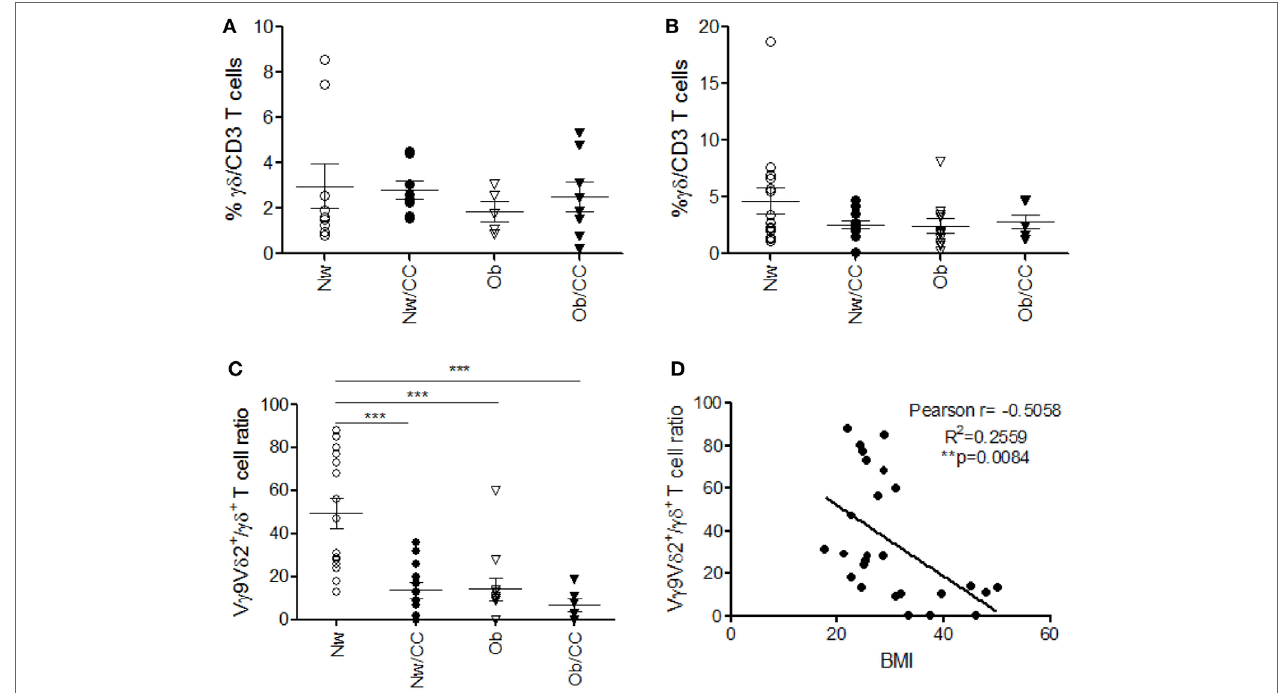
FigUre 5 | Obese (Ob) and colorectal cancer (CRC)-affected individuals exhibit normal frequencies of peripheral blood (PB) and visceral adipose tissue (VAT)- associated total γδ T lymphocytes but a significantly reduced V γ 9V δ 2/ γδ T cell ratio in PB that correlates with body mass index (BMI). VAT stromal vascular fraction (SVF) and PB lymphocytes isolated from lean normal weight (Nw), Ob, lean affected by CRC (Nw/CC), and Ob affected by CRC (Ob/CC) donors were analyzed by flow cytometry. Frequency of total γδ T cells (among CD3 + T cells) was evaluated in SVF (a) and PB (B) . (c) V γ 9V δ 2/ γδ T cell ratios (PB) were calculated in the four categories of donors. Each dot represents an individual donor. Mean ± SEM is shown for each group. *** p < 0.001, by analysis of variance. (D) Pearson’s correlation ( r ) between the V γ 9V δ 2/ γδ T cell ratio and BMI in Nw and Ob subjects (** p <